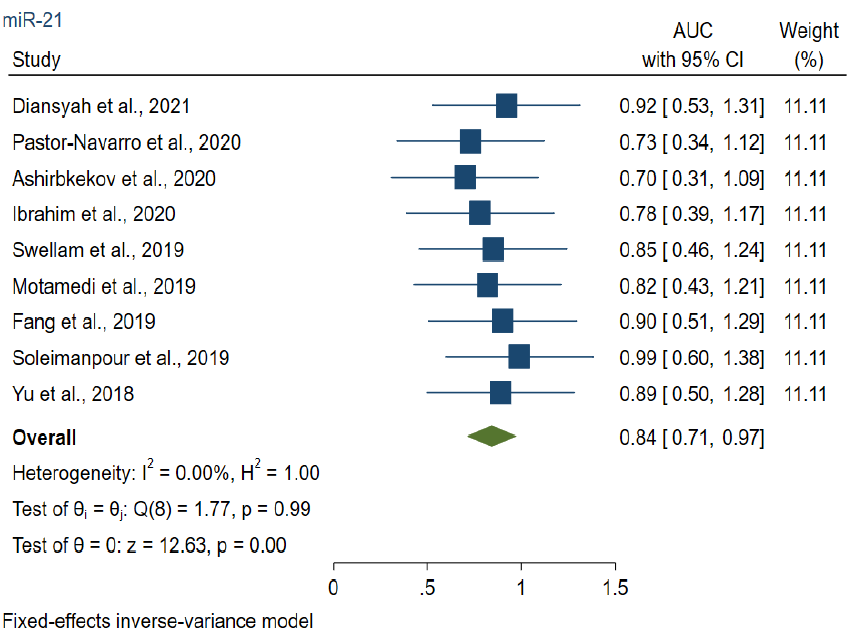
Fig. 8. AUC of miR-21 to diagnose breast